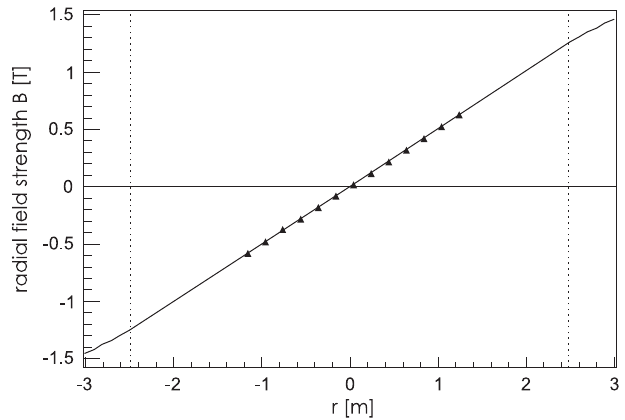
FIG. 10. Hall probe measurements (triangles) are plotted against the distance from the center of the quadrupole and compared to the design simulation (solid line). The dashed lines indicate aperture limitations originating from the central non- (cid:10) (cid:7) 1 : 5 T . magnetic cylinder. The field gradient amounts to 503 T = m i